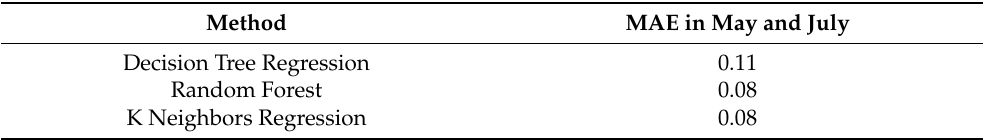
Table 2. Comparison between three different machine-learning methods applied to the analysed data. MAE (Mean Absolute Errors) obtained for May and July were